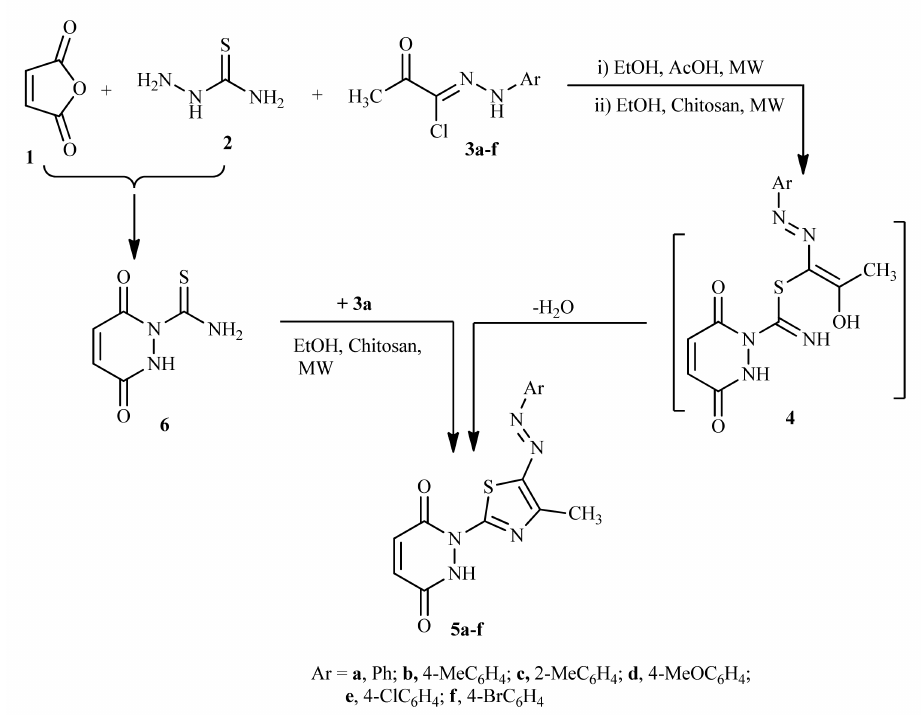
Scheme 1. Synthesis of arylazothiazole derivatives 5a–f